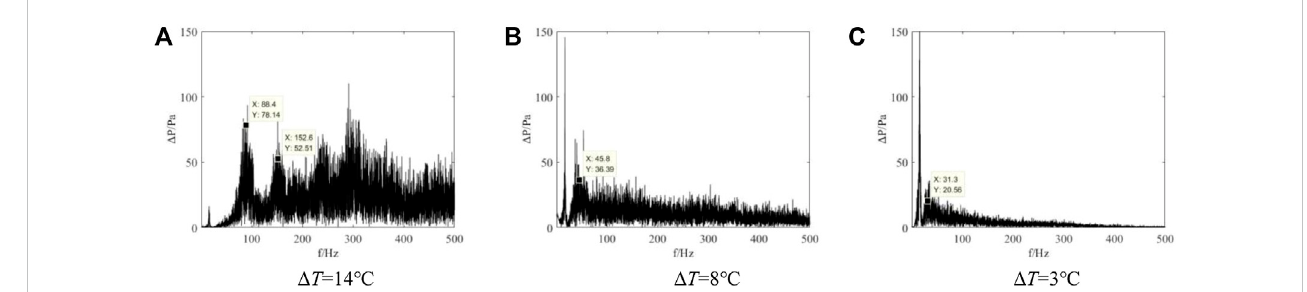
Noise frequency-domain signal when Ge = 220 kg/m 2 · s.